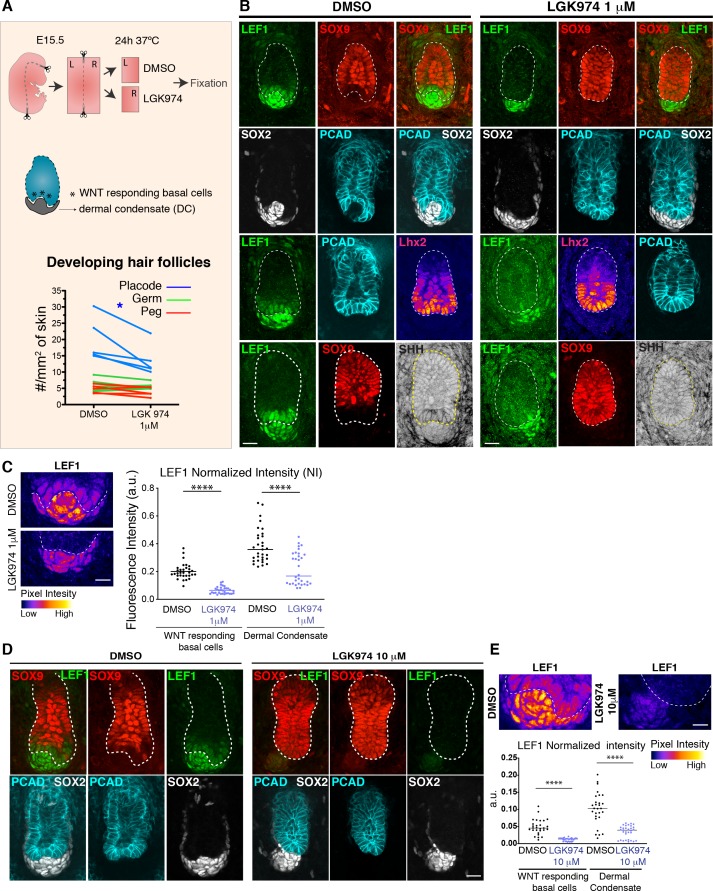
Hair bud progenitors cannot maintain their fate upon WNT inhibition.(A) Experimental design and results of pharmacological WNT inhibition in embryonic skin explants exposed to the porcupine inhibitor LGK974. Note that placode/bud numbers were significantly reduced after 24 hr treatment with 1 mM LGK974, a porcupine inhibitor and established blocker of WNT signaling (n = 5 embryos where each line represents the average number of placodes, germs and pegs per skin mm2, on an independent explant. *p<0.05; paired Student t test). (B) Immunofluorescence of explants from experiment in (A). Note that upon 1 mM LGK974 treatment, significant alterations appear in WNT signaling (nuclear LEF1), specifically within the normally WNThi bud progenitors that border the dermal condensate border. Note also that SHH is suppressed in these progenitors while SOX9 (normally restricted to WNTlo hair follicle cells) is induced, reflecting the inability of WNThi bud progenitors to maintain their fate when WNT signaling is inhibited. Note also that developing hair follicles are unable to envelope the dermal condensate. Scale bars, 20 μm. (C) LEF1 immuno-intensity, color-coded according to pixel intensity, reveals an overall reduction in nuclear LEF1 within both hair bud progenitors and dermal condensate cells upon 1 mM LGK974 treatment. Values were normalized to DAPI (DMSO n = 31 and LGK974 = 32 developing hair follicles ****p<0.0001, Mann-Whitney test). Scale bar, 20 μm. (D) Whole-mount immunofluorescence images of representative developing hair follicles from E15.5 explants treated with DMSO and 10 mM LGK974. Note that LEF1 is lost from bud progenitors, which concomitantly gain SOX9 expression, normally restricted to WNTlo hair follicle cells. Note that at these higher concentrations of WNT-inhibitor, the effects described in (B) are now more pronounced. (E) Total LEF1 in the dermal condensate and basal progenitors was measured and normalized to DAPI. Note that basal hair follicle progenitors quantitatively lost nearly all of their LEF1/WNT-signal, while even at this high concentration of porcupine inhibitor, there is still some residual LEF1/WNT-signal in the dermal condensate cells (DMSO n = 28 and LGK974 = 31 developing hair follicles; ****p<0.0001, Mann-Whitney test). White dotted lines demarcate the epithelial-mesenchymal boundary. Scale Bar, 20 μm; a.u. arbitrary units.Figure 6—figure supplement 2—source data 1.Source data for the graphs shown in Figure 6—figure supplement 2A, C, and E.